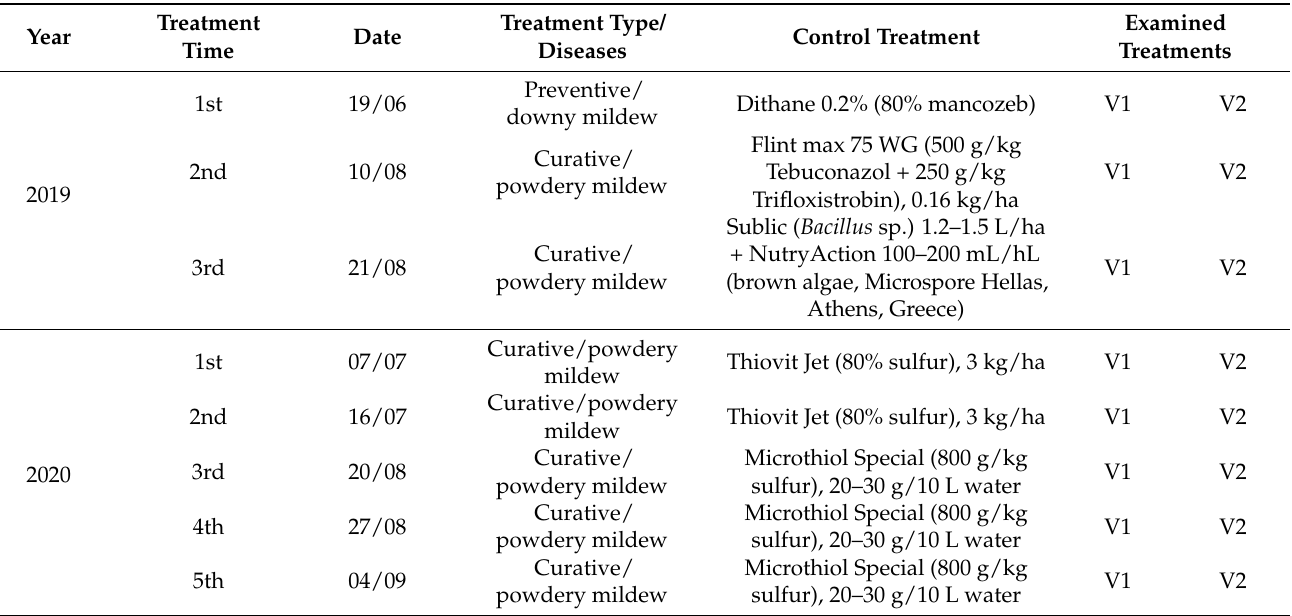
Table 1. Treatments application to the experimental